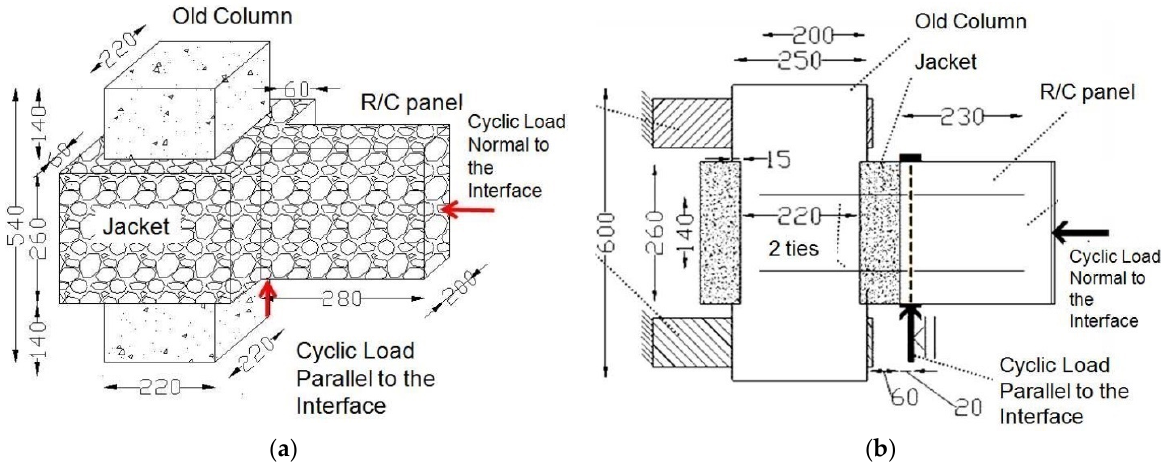
Figure 21. (a) Experimental setup to study the force transfer mechanism between portions of the RC panel and the jacketed RC column with or without steel ties. ( b ) Cross ‐ section [60–62]. Twenty ‐ three specimens were built at the same time with the same geometry and the same quality concrete. Three of these specimens were built without any steel ties whereas the rest were provided with steel ties of the same steel grade having diameters varying of 8 mm, 10 mm, 12 mm, and 14 mm. Figure 21b depicts a cross ‐ section of such specimens wherein the upper and lower parts of the “old” column are rigidly supported by the strong reaction frame. Initially, the load normal to the interface was applied as indicated in this figure, keeping its amplitude constant during one test. Then, a cyclic load with a direction parallel to the interface was applied with an eccentricity of 20 mm from this interface. The amplitude of this load was gradually increased until a limit state condition was reached. By comparing the nonlinear behaviour of the specimens with steel ties to that of the control specimen (without the steel ties), the non ‐ linear shear force versus the relative sliding displacement at the interface due to the presence of the steel ties could be determined. This was used in the current numerical methodology to define the nonlinear constitutive behaviour of the second group of links in their tangential direction (parallel to the interface).